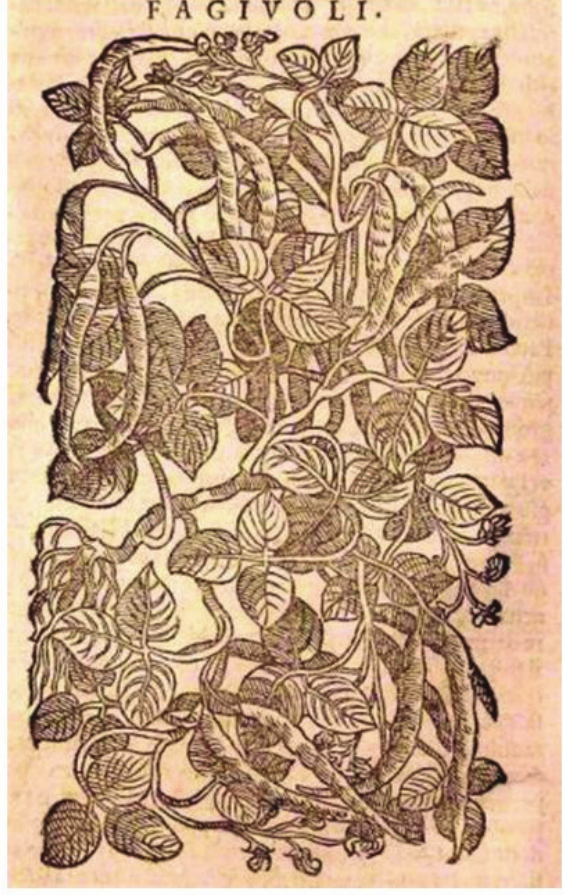
Figure 1. Picture of common bean plant (called ‘Fagiuoli’) from Commentarii in Sex Libros Pedacii dioscorides of Pier Andrea Mattioli